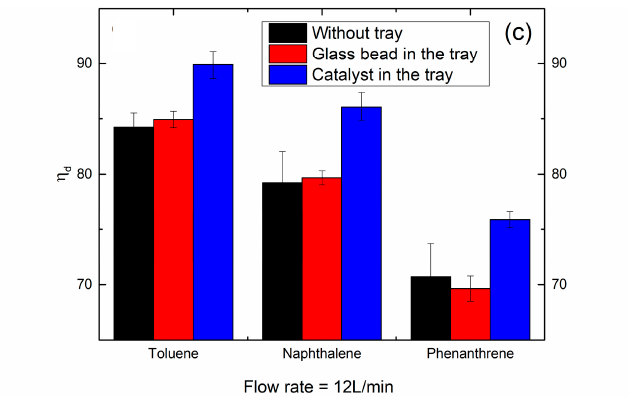
Figure 19. Effect of catalyst on energy efficiency at flow rates of 6 NL/min, 9 NL/min and 12 NL/min.